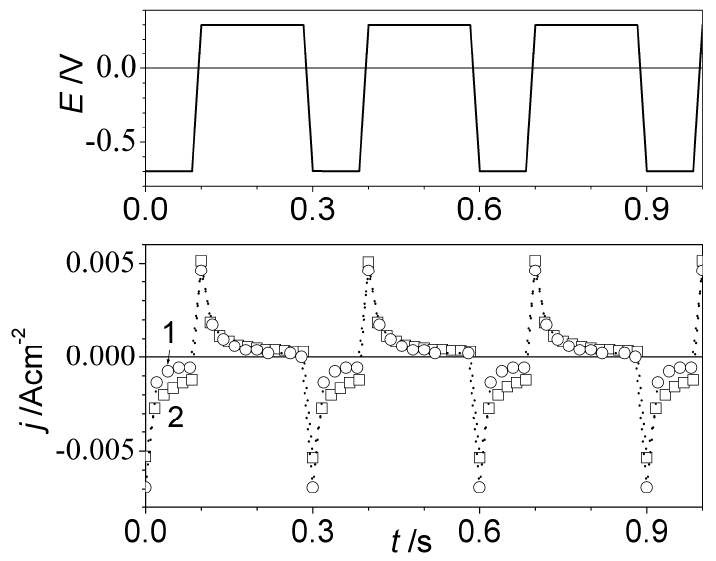
Fig. 5 The input square wave potential versus time, and the resulting current versus time curves: for the Fe Ni Cr electrodeposit 1–A, and 2–B sample. 29 51 20 During the square wave potential cycling passivation, the reactions are expected at –0.7 V and involve the partial reduction of the higher valencey oxides to lower va- lence